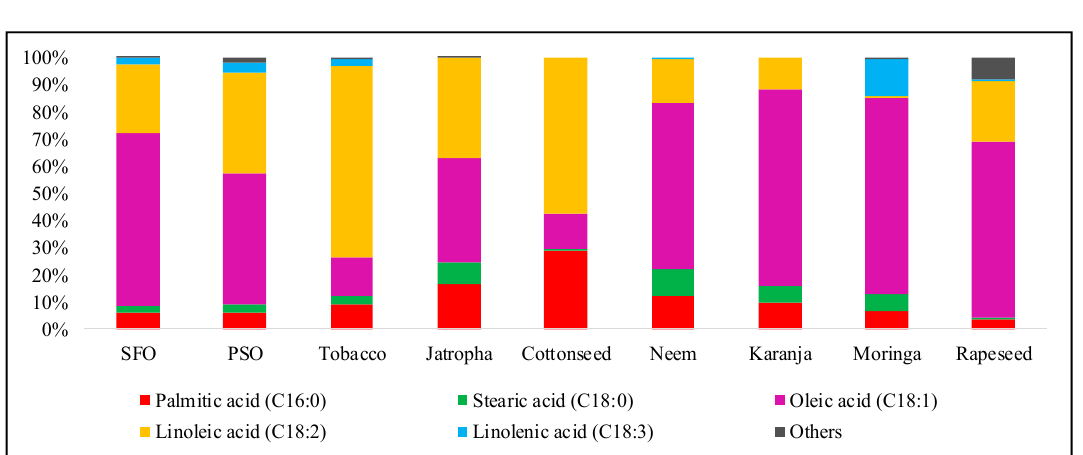
Figure 3. Comparison of the fatty acid composition of SFO and other non-edible vegetable oils.